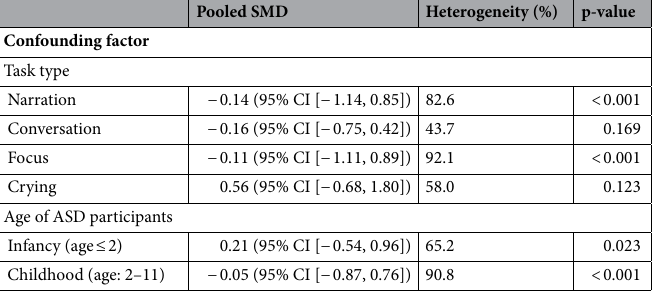
Table 3. Subgroup analyses for the difference of pitch standard deviation between ASD and TD groups. The elicitation tasks and the age of participants were confounding factors.